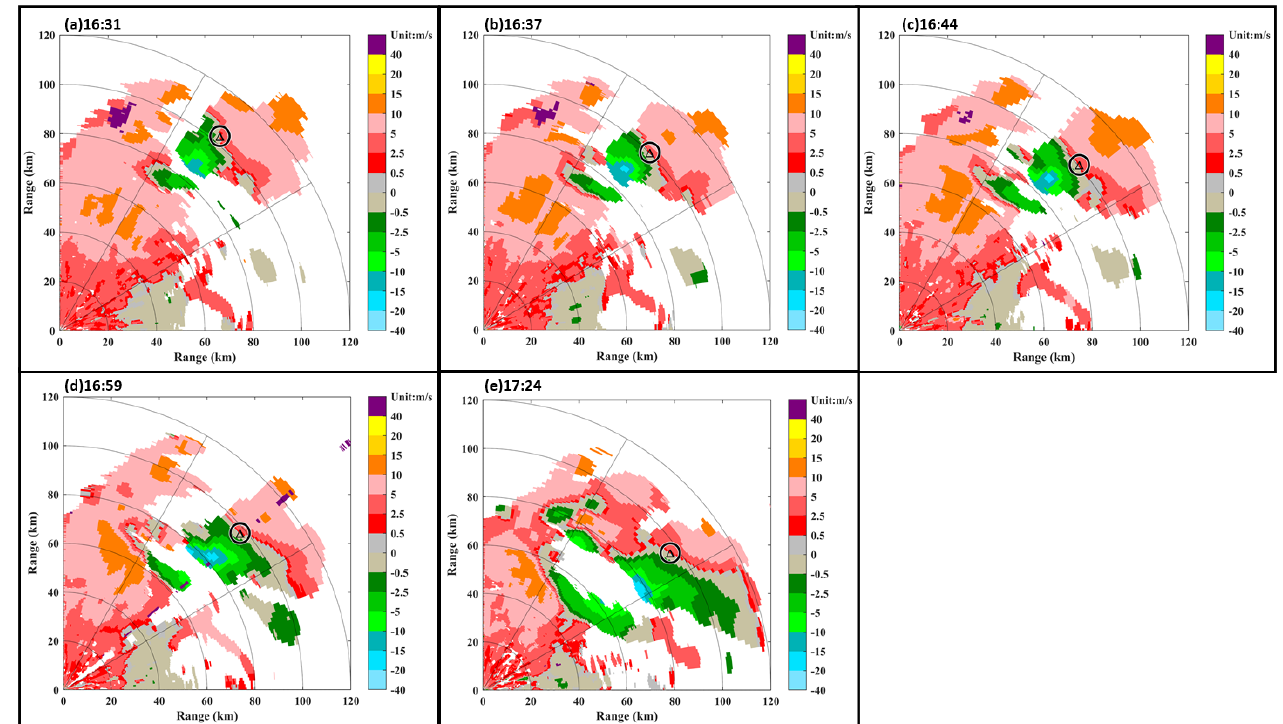
Figure 17 Figure 17. Radar echoes from Jinan, Shandong on 27 June 2009. ( a ) 16:31, ( b ) 16:37, ( c ) 16:44, ( d ) 16:59, and ( e ) 17:24 are the radial velocity PPI at an elevation angle of 0.5 ◦ . The black triangle indicates the center of the downburst, and black circle indicates the range of the